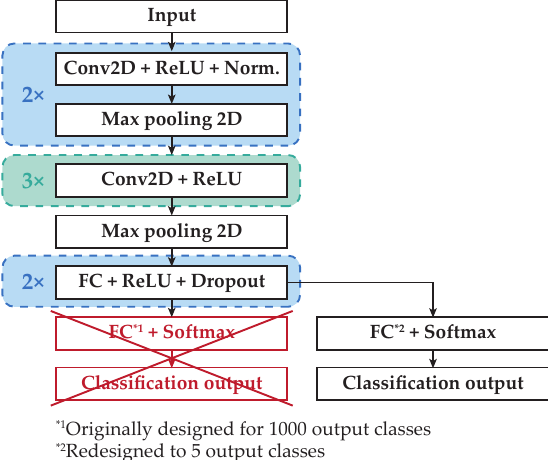
Figure 13. Architecture modification of the pretrained